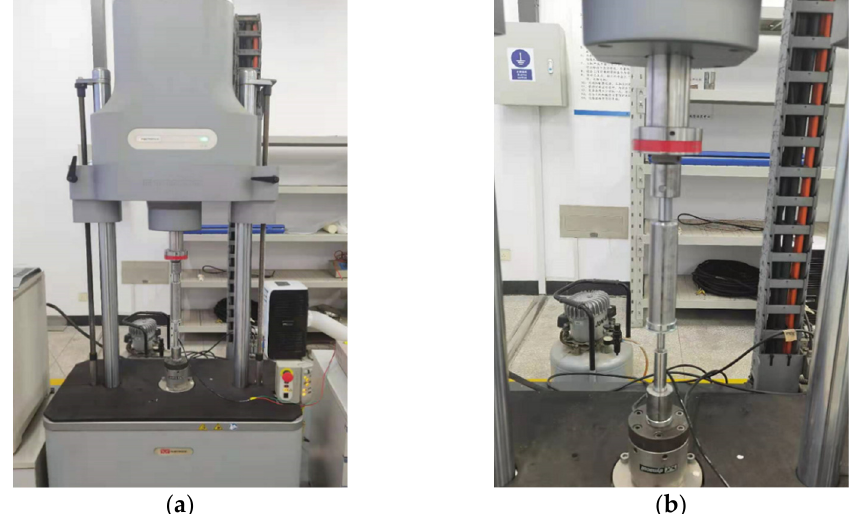
Figure 3. Dynamics test of the MRF damper. ( a ) E10000 electronic dynamic testing machine; ( b ) MRF damper installed on the test machine.